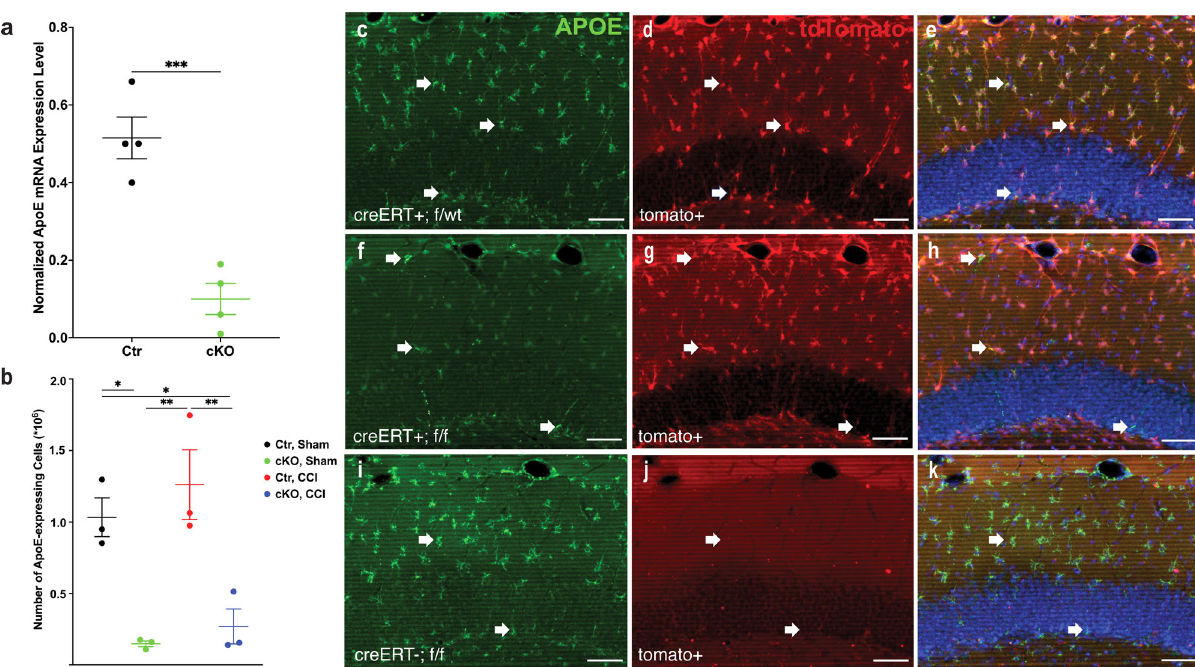
Fig. 2 Tamoxifen and aldh1l1-creERT-dependent knockdown of ApoE expression in astrocytes. a Quantitative RT-PCR demonstrates a signi fi cant reduction in ApoE mRNA in the hippocampus in conditional knockout mice after treatment with tamoxifen. b Signi fi cant reduction in the number of ApoE- expressing cells in the hippocampus in aldh1l1-creERT; apoe f/f mice in both sham-operated and CCI mice. c – e Seven weeks after tamoxifen in control littermates, ApoE expression was observed in most aldh1l1-dependent tdTomato-expressing cells in the hippocampus, as shown by arrows. f – h In apoe f/f mice, ApoE expression in tdTomato-expressing cells is dramatically reduced. i – k In the absence of aldh1l1-creERT, the expression of ApoE in the hippocampus remained unchanged in mice receiving tamoxifen and the expression of cre-dependent tdTomato was not observed. This indicates that no spontaneous recombination of loxp- fl anked DNA fragments was observed. Data are presented as means ± SEM, * P < 0.05; ** P < 0.01; *** P < 0.001. Scale bar = 50 µ